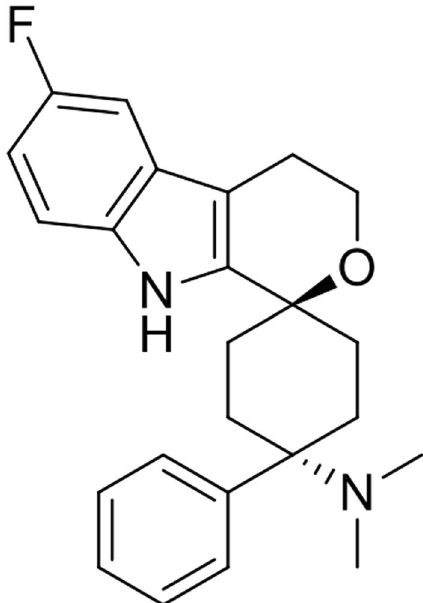
Figure 1. Cebranopadol.